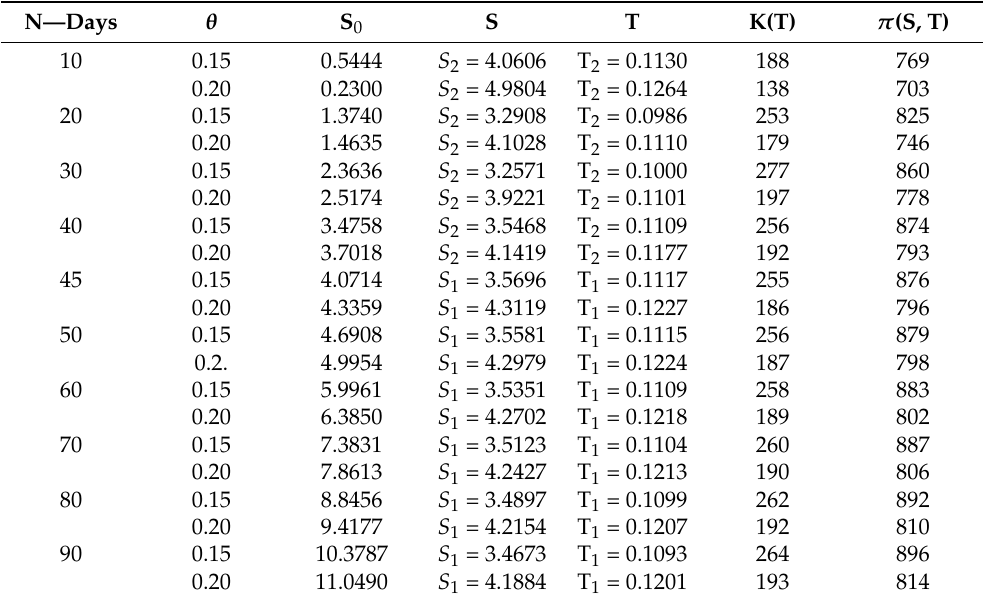
Variations in net profit when γ